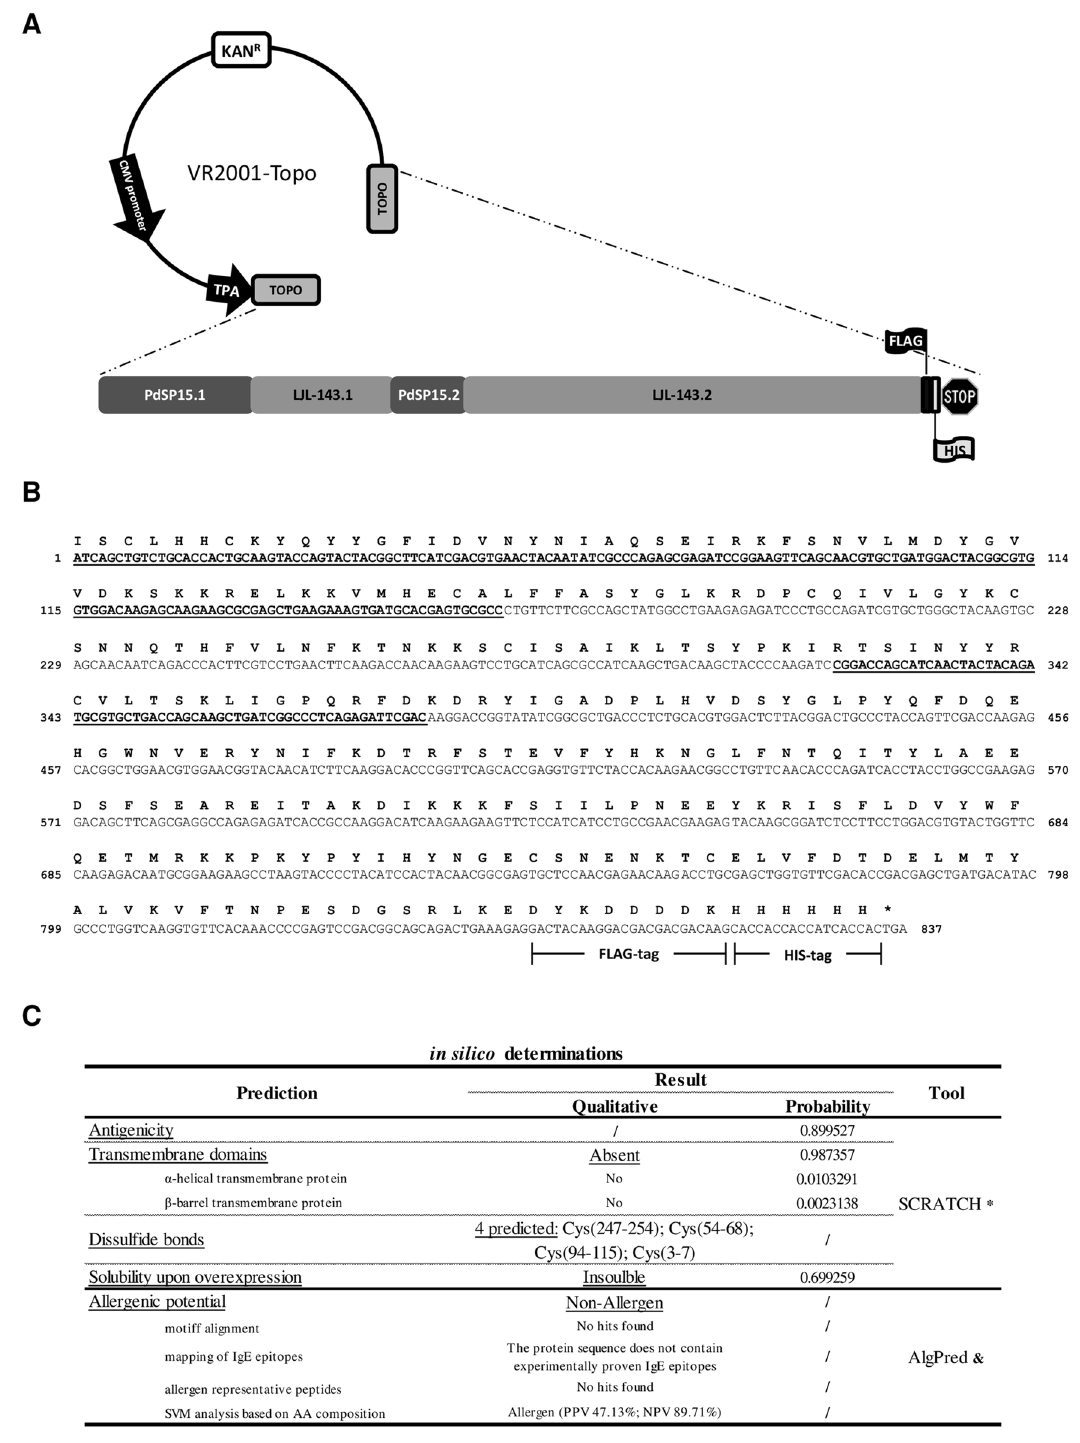
Figure 3. Engineering a multi-sand fly species based anti- Leishmania vaccine. A single DNA-based vaccine was engineered, considering a reverse vaccinology approach applied to the two salivary proteins this study focuses on: PdSP15 and LJL-143. The scheme of the final DNA vaccine, consisting of the VR2001-TOPO vector backbone and the fusion salivary antigen coding sequence, composed by the selected immunogenic portions of the two salivary proteins joined contiguously in an interpolated manner, a FLAG-tag, a HIS-tag and a stop codon is represented ( A ). The final sequence coding for the fusion salivary antigen (codon optimized for the mammalian codon usage bias), used in the cloning approach, as well as the respective translation, is shown ( B ). The underlined nucleotides code for the portions of PdSP15, while the non-underlined ones code for the portions of LJL-143. FLAG- and HIS-tags coding sequences are highlighted. The fusion protein amino- acid sequence was subjected to in silico predictions of antigenicity, solubility upon overexpression, presence of transmembrane domains, disulphide bonds formation and allergenic potential, whose quantitative and/or qualitative results are represented ( C